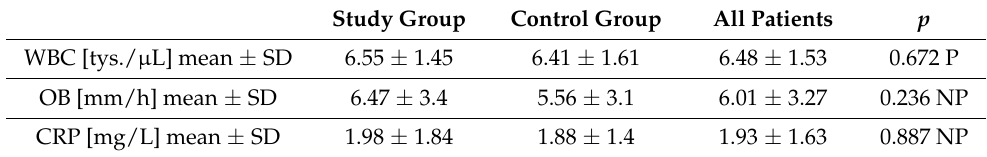
Table 2. Comparison of individual blood laboratory parameters WBC, OB, CRP.